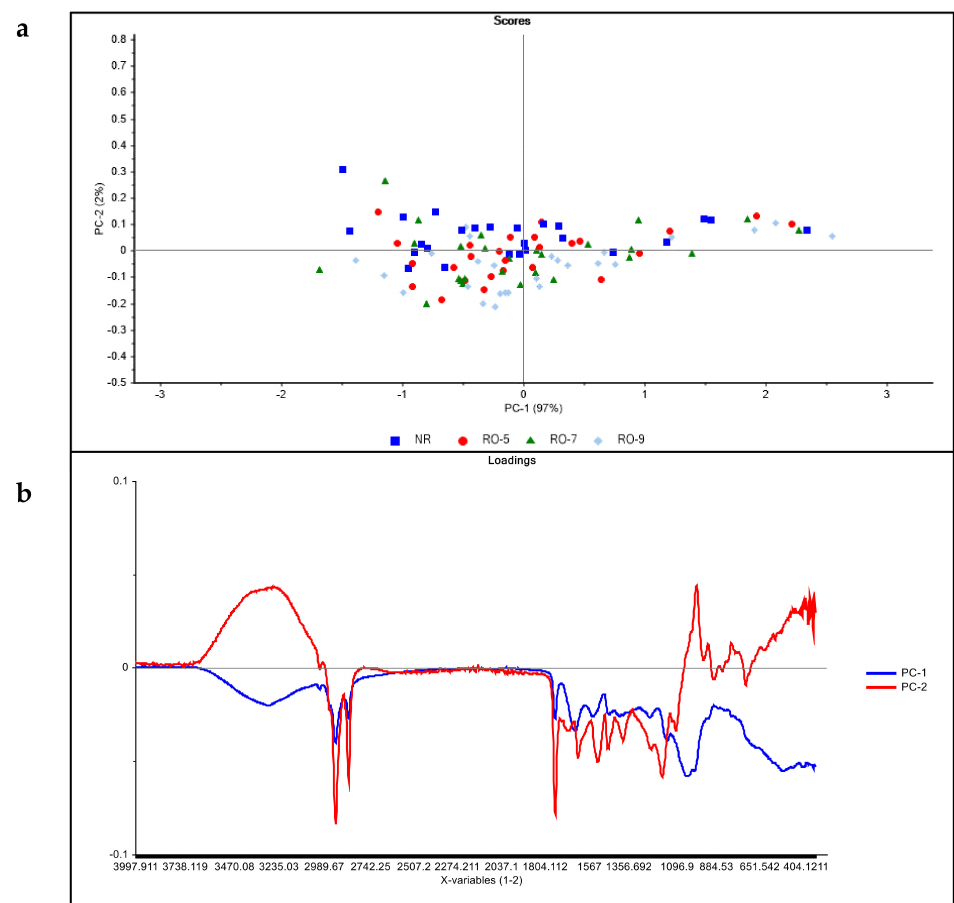
Figure 3. Principal component score plot ( a ) and loadings ( b ) of raw and roasted AS samples analysed by MIR